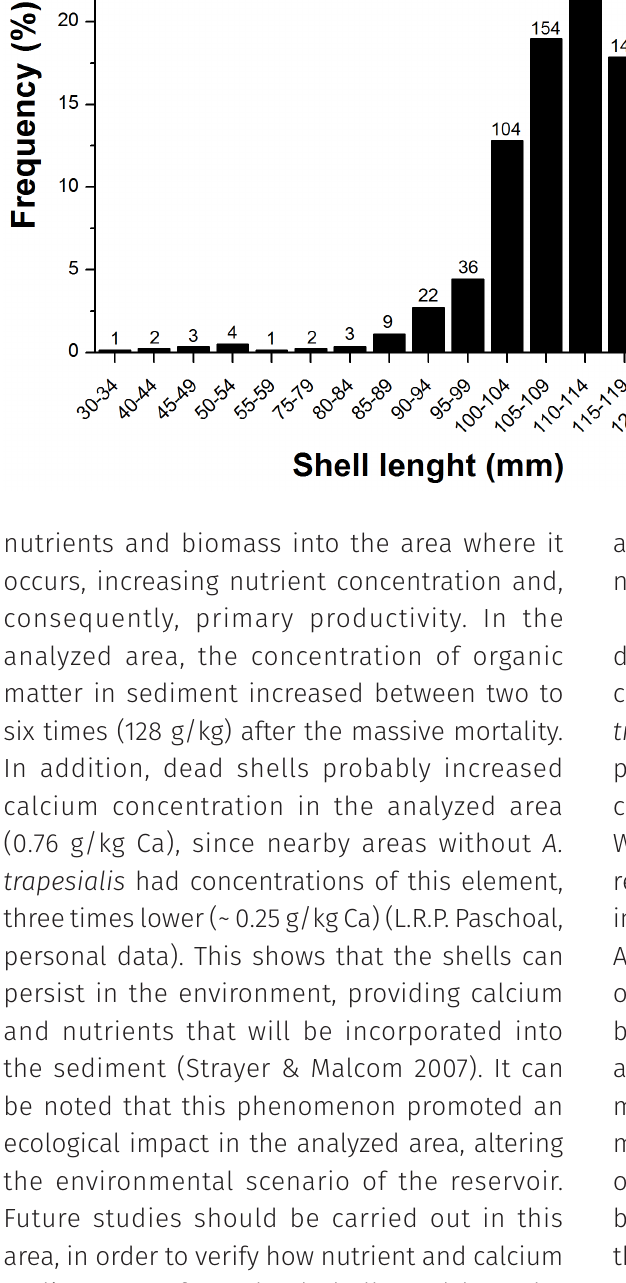
Figure 5. Shell length-frequency distributions of Anodontites trapesialis dead shells (N: 812) at Furnas HPS reservoir. Values on the top of the columns are corresponded to the total number analyzed